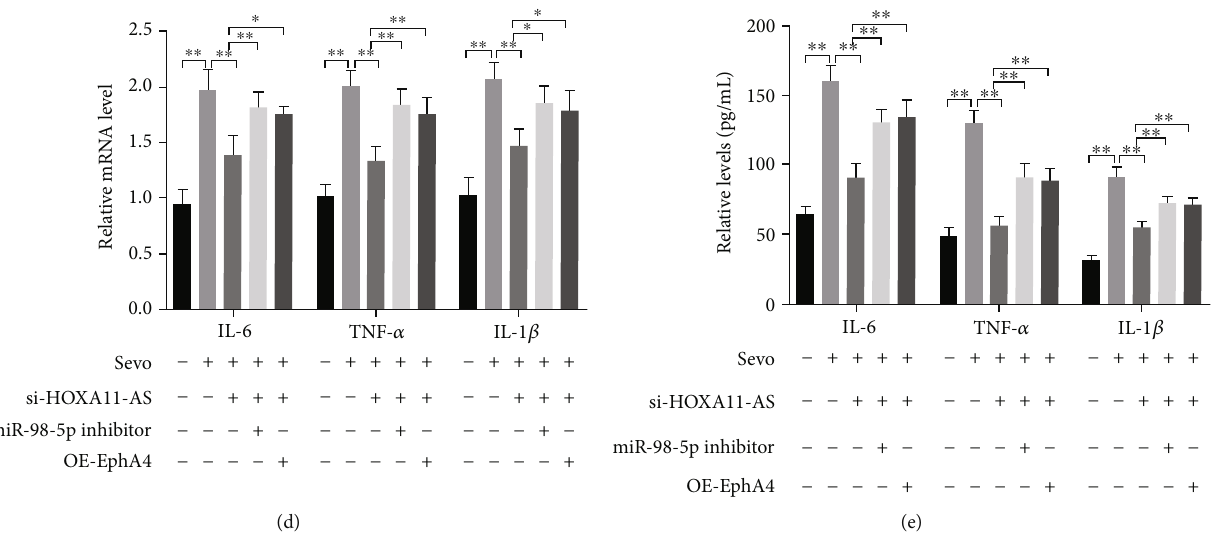
Figure 6: HOXA11-AS regulates sevo fl urane-induced neuronal apoptosis and neuroin fl ammation through the miR-98-5p/EphA4 molecular axis. (a, c) Western blot detection of protein expression in neurons cells. (b) TUNEL staining to detect neuronal apoptosis. (d) RT-qPCR detect the mRNA expression of in fl ammatory factors. (e) ELISA detects the in fl ammatory factors levels. ∗ P < 0 : 05 , ∗∗ P < 0 : 01